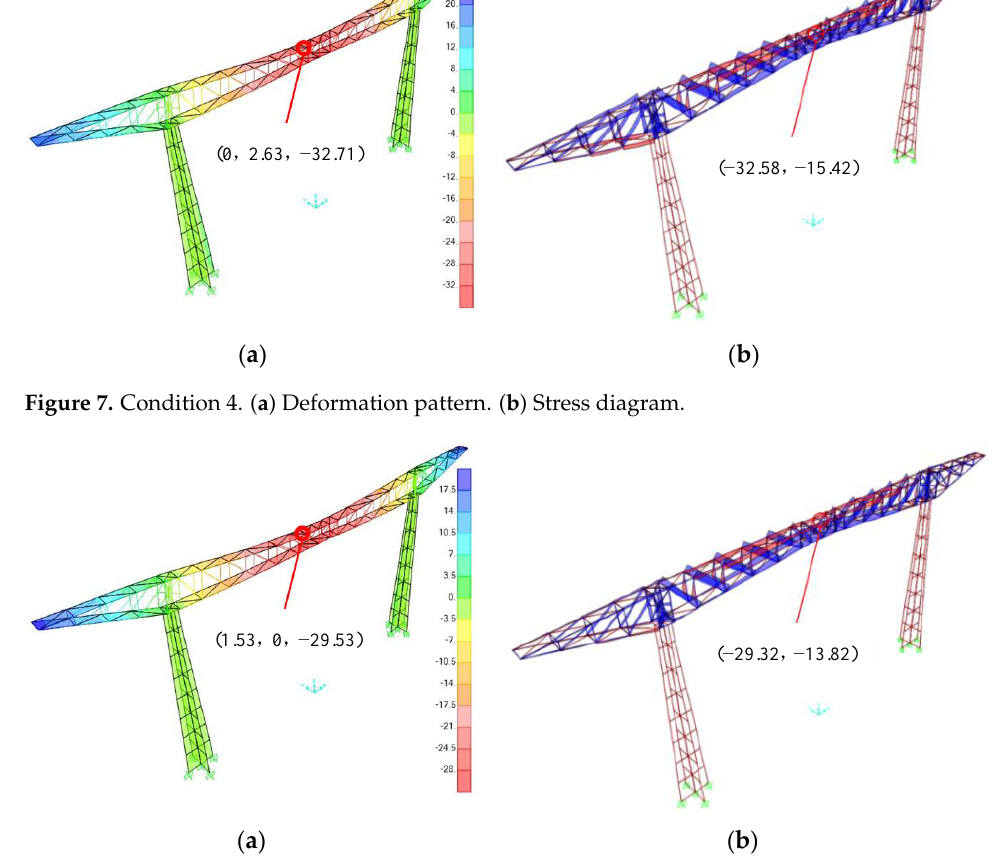
Figure 8. Condition 5. ( a ) Deformation pattern. ( b ) Stress diagram.